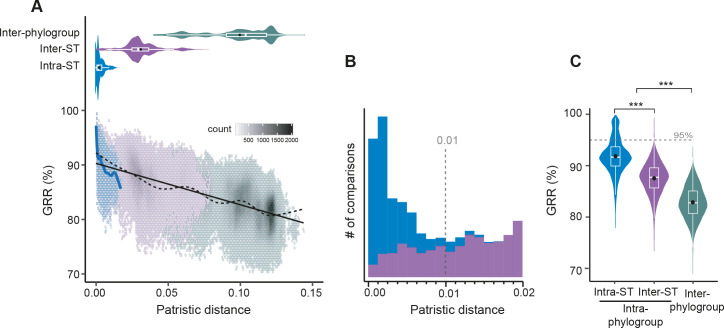
Evolution of Gene Repertoire Relatedness (GRR) with time.A. [Top] Violin plots of the patristic distance computed between pairs of intra-ST (in blue), inter-ST (in purple), and inter-phylogroup (in water green) genomes. [Bottom] Association between GRR and the patristic distance across pairs of genomes. Due to the large number of comparisons (points), we divided the plot area in regular hexagons. Color intensity is proportional to the number of cases (count) in each hexagon. The linear fit (black solid line, linear model (lm)) was computed for the entire dataset (1,294 genomes, Y = 90.2–75.7*X, R2 = 0.49, P<10−4). The spline fit (generalized additive model (gam)) was computed for the whole (in black dashed line) or the intra-ST (in blue solid line) comparisons. There was a significant negative correlation between GRR and the patristic distance (Spearman’s rho = -0.67, P<10−4). B. Stacked bar plot of the number of intra-ST (in blue) and inter-ST (in purple) comparisons at short evolutionary scales. C. Violin plots of the intra-ST, inter-ST and inter-phylogroup GRR (%). (A-B-C) All the distributions were significantly different (Wilcoxon test, P<10−4), the same color code was used and described in panel A.